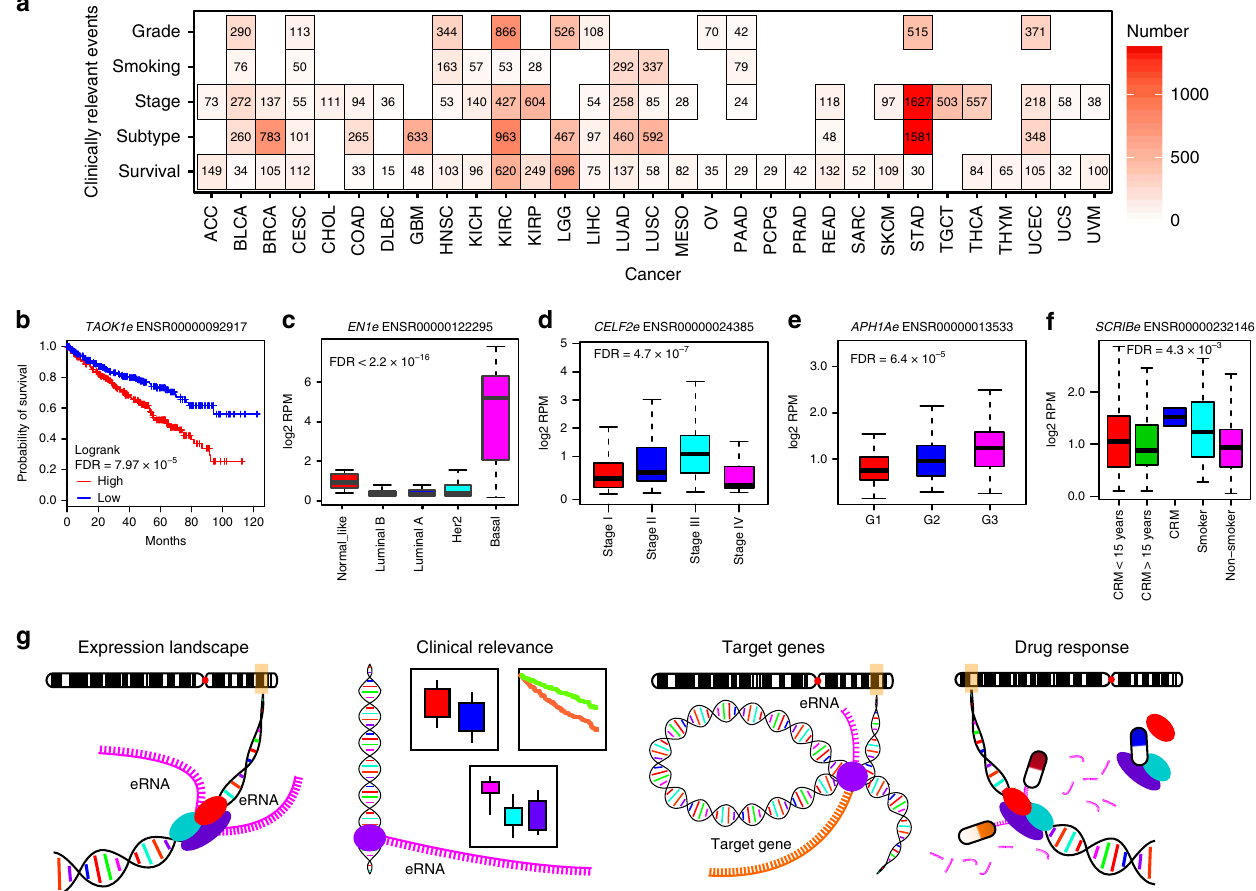
Fig. 6 Clinically relevant eRNAs and the eRNA data portal in cancer (eRic). a Number of clinically relevant eRNAs across different cancer types. For survival analyses, we use cox model to analyze the relationship between eRNA expression and survival time, and considered FDR < 0.05 as signi fi cant. For other clinical relevance, we used Student ’ s t test to test the difference between two groups and analysis of variance (ANOVA) to test the difference among multiple groups, and considered FDR < 0.05 as signi fi cant. Scale bar denotes number of clinically relevant eRNAs. b – f Examples of clinically relevant eRNAs for patient survival time ( b ), cancer subtype ( c ), tumor stage ( d ), tumor grade ( e ), and patient smoking history ( f ). The boxes in ( c – f ) show the median± 1 quartile, with whiskers extending from the hinge to the smallest or largest value within 1.5 interquartile range from the box boundaries. g The four modules in eRic: expression landscape, clinical relevance, putative target genes, and drug